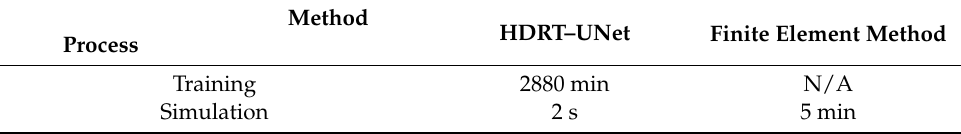
Table 2. Time used to simulate temperature sites.